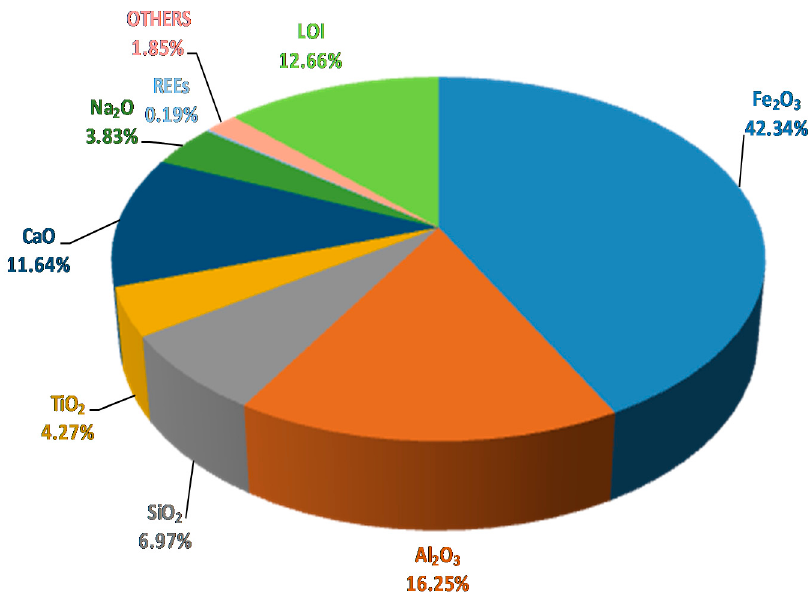
Figure 2. Bauxite residue chemical analysis.